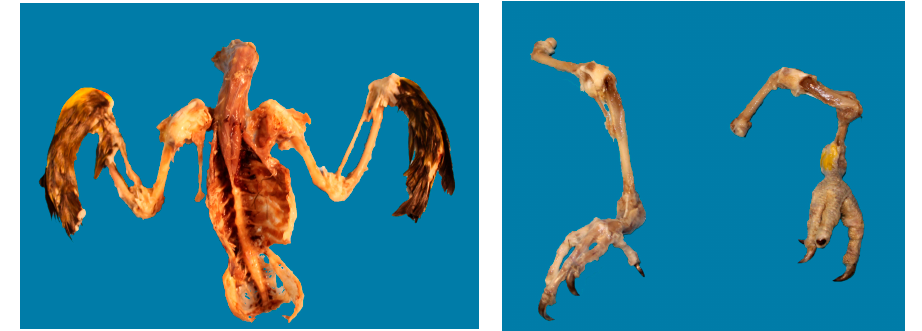
Figure 3. Chronic clockwise deviation of the pelvis and sacrum and multiple chronic rib fractures ( left ); Chronic non-union mid-diaphysis fracture of the left tibiotarsus with firm callus and chronic non-union fracture of the proximal metaphysis of the right femur and tibiotarsus ( right ).